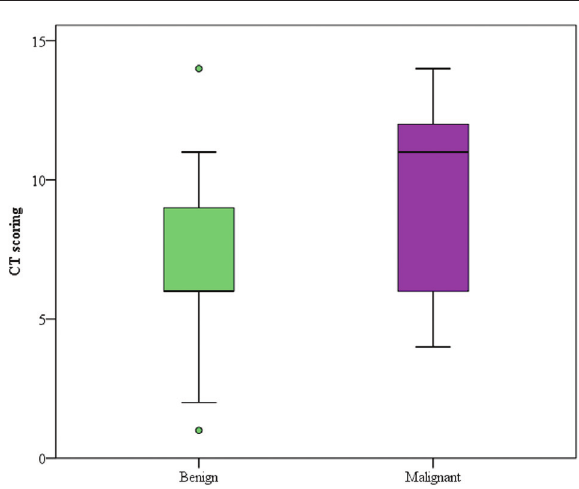
Comparison between the two groups studied according to computed tomography scoring.